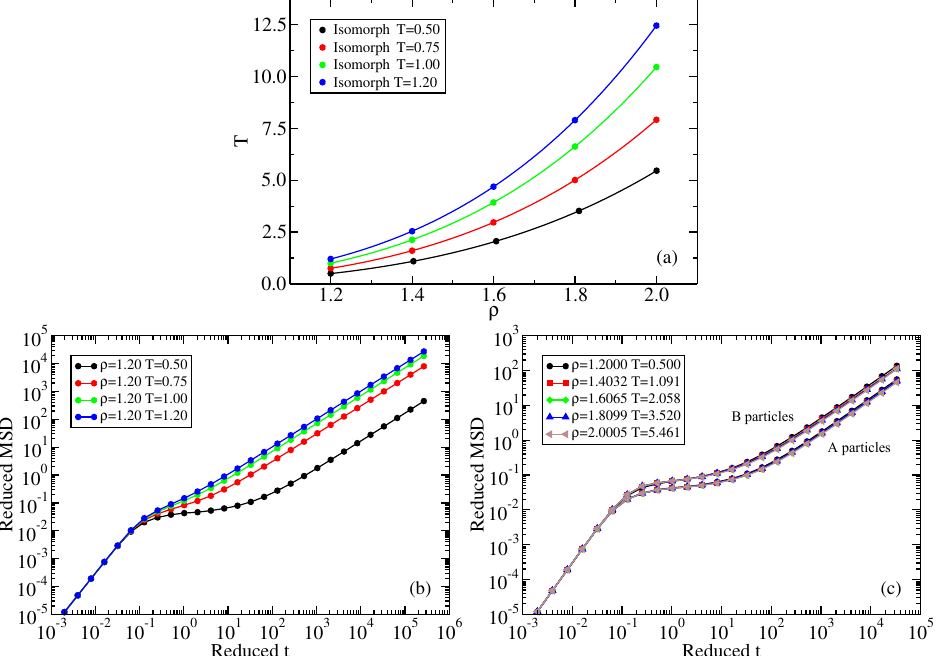
Figure 6. Kob–Andersen (KA) binary LJ system characteristics. ( a ) Four isomorphs. ( b ) Reduced A particle MSD at four state points of the ρ = 1.20 isochore. ( c ) Reduced MSD along the lowest-temperature isomorph (reference state point ( ρ , T ) = ( 1.20,0.50 ) ) for the A and B particles, respectively, confirming that the state points are isomorphic by collapsing the reduced-unit mean-square displacements as a function of the reduced time. Note that the B particles are considerably faster than the A